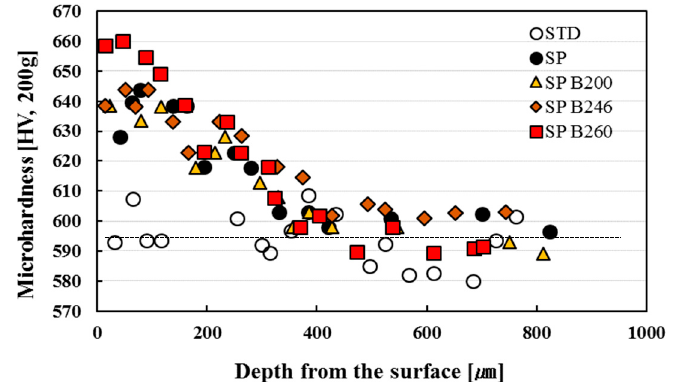
Figure 5. The distribution of micro hardness according to the depth from the surface.